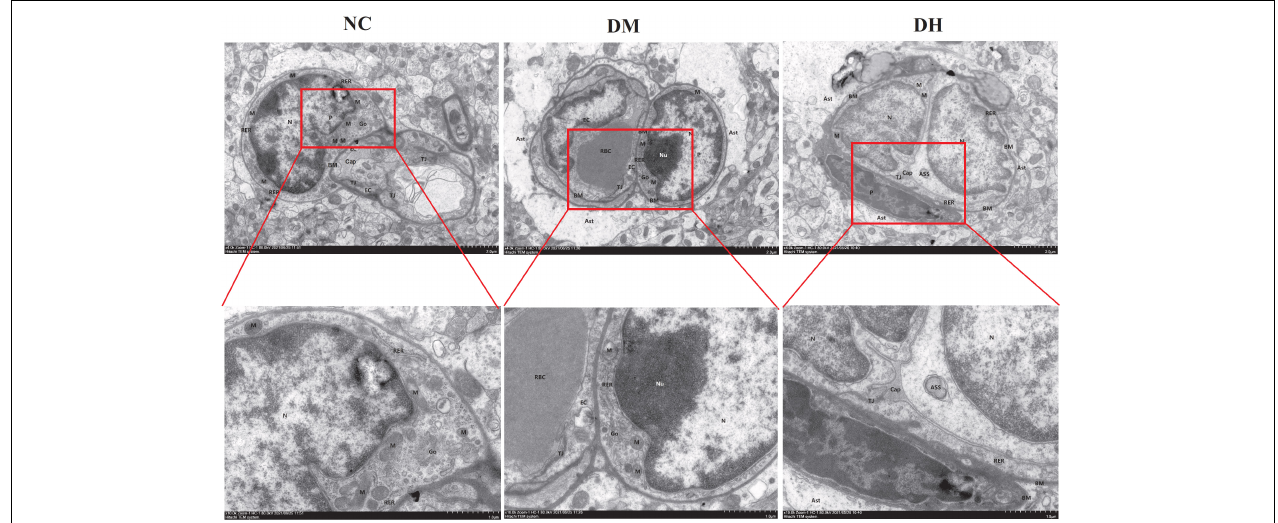
FIGURE 5 | Severe hypoglycemia aggravated BBB structural damage and pericyte damage. Representative images of hippocampal BBB and pericyte morphology under transmission electron microscopy are shown. Ast, astrocyte; P, pericyte; N, nucleus; Nu, nucleolus; Go, Golgi apparatus. N = 3 per group.